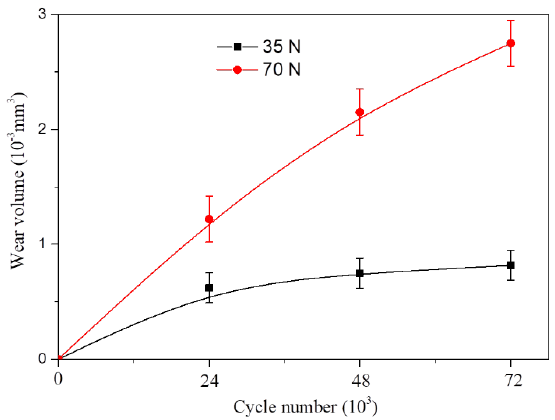
Figure 6. Wear volume of the nitrided specimens under the load of 35 N and 70 N.